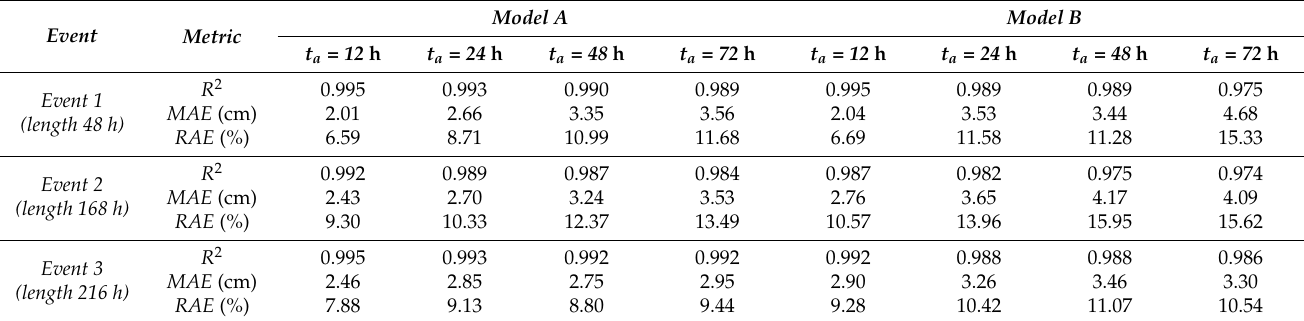
Figure 7. Event 2, extreme storm tide event forecasting for the period 27 October–3 November 2018, comparison between measured time series and predicted values: Model B, t a = 12 h (on the left ), t a = 72 h (on the right ).